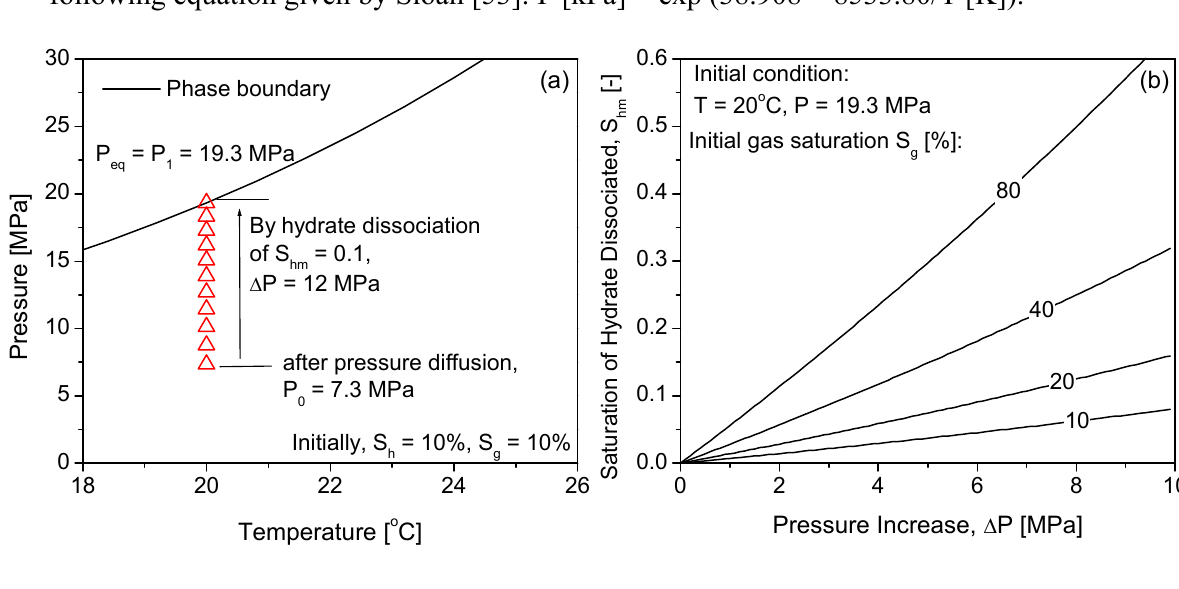
Figure 2. Dissociation of methane hydrate against depressurization: ( a ) pressure generation by hydrate dissociation and ( b ) the volume fraction of hydrate dissociated to reestablish the equilibrium pressure. Note that the thermodynamic phase boundary is plotted using the following equation given by Sloan [53]: P [kPa] = exp (38.908 − 8533.80/T